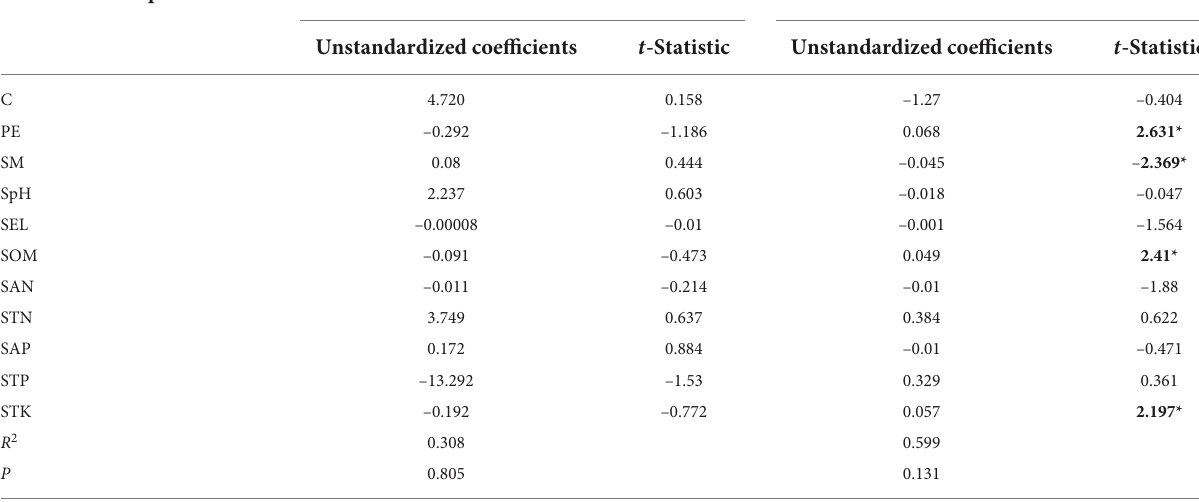
TABLE 2 Linear regression analysis of nitrogen (N) and phosphorus (P) concentrations in M. lutarioriparius and environmental parameters in the field investigation. Environmental